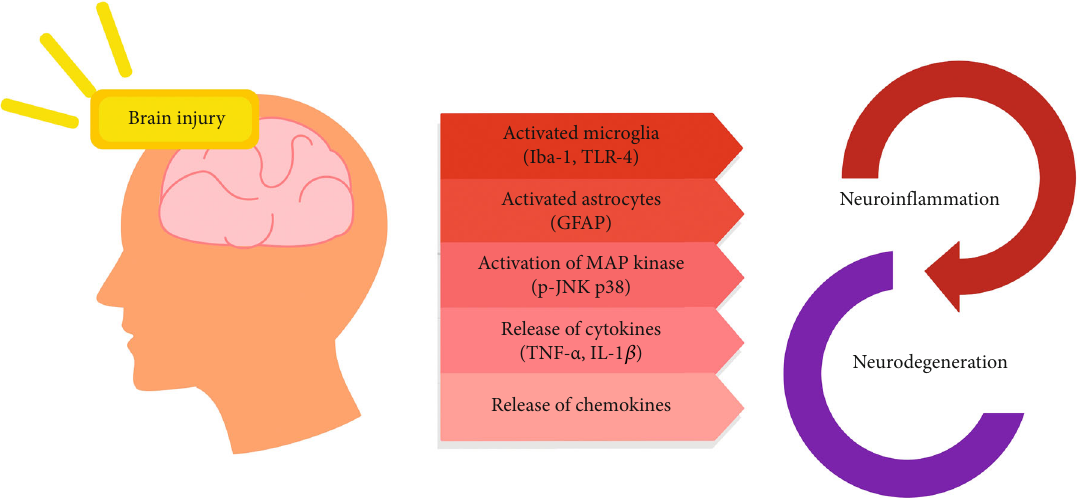
Figure 2: Neuroprotective and anti-in fl ammatory e ff ects of the